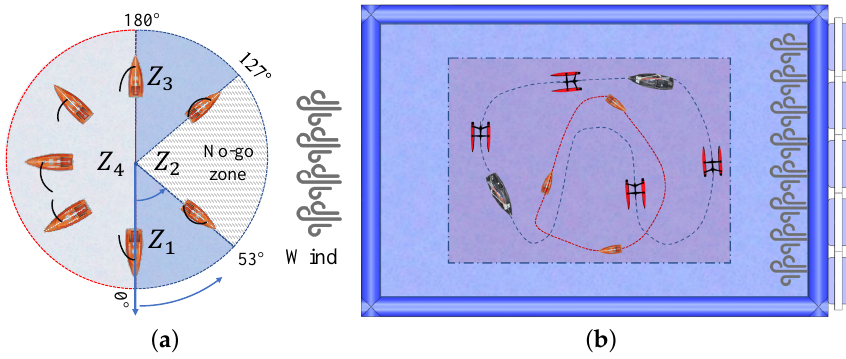
Figure 7. Points of sail and path examples. ( a ) Different sail modes have been adopted in different zones. The wind blows from the right-hand side. ( b ) There are two path examples. The darker rectangle represents the active sailing zone. The wind direction is from right